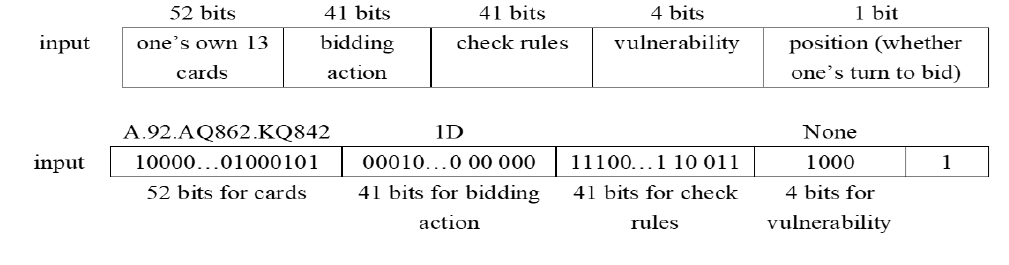
Figure 3. An example of model input.